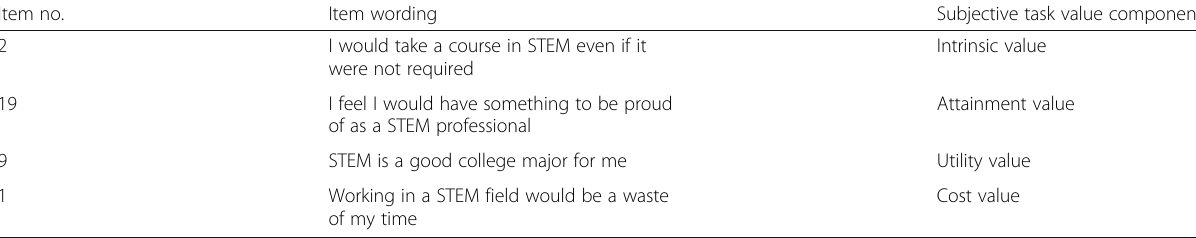
Table 3 Perceived value of STEM fields subscale items and their subjective task value match Item